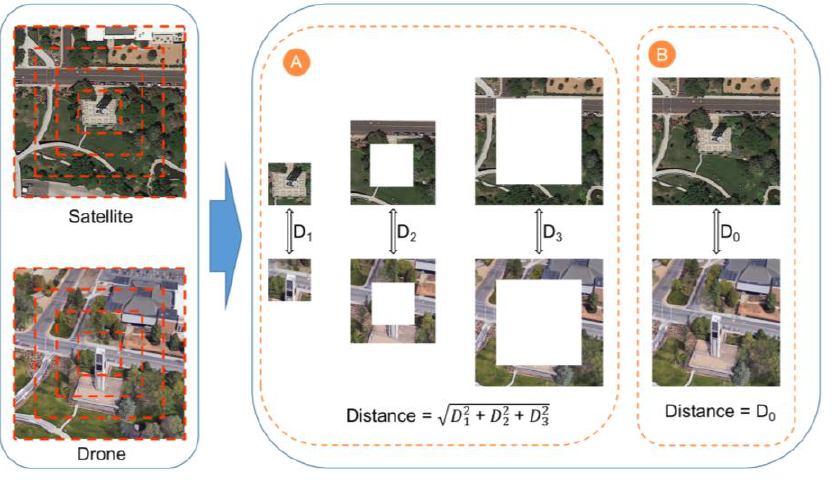
Figure 2. Square-ring feature partition strategy. ( A , B ) Two ways to calculate distance between image features.